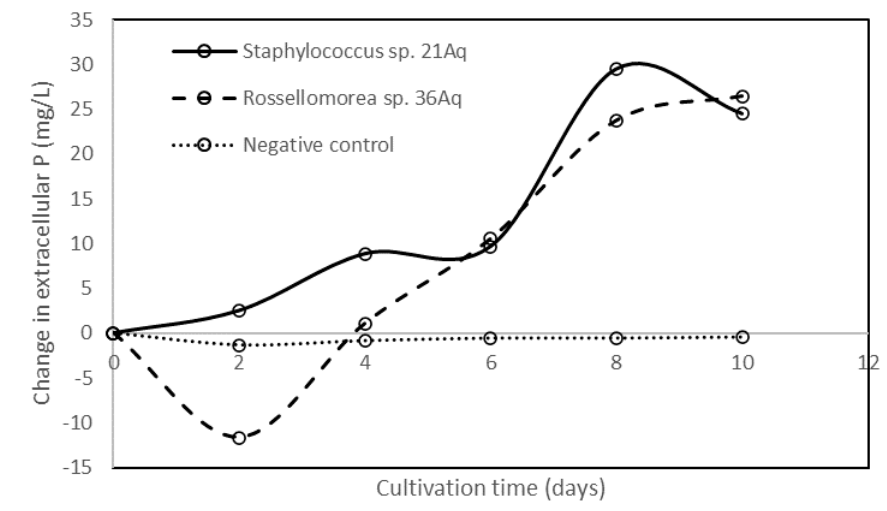
Figure 3. Change in the phosphorus concentration (mg L − 1 ) in PSM medium (with respect to uninoculated control) after inoculation with Staphylococcus sp. 21Aq or Rossellomorea sp. 36Aq strains. The Bacillus sp. 37Aq strain with no extracellular phytate hydrolysis ability was used as the negative control illustration.